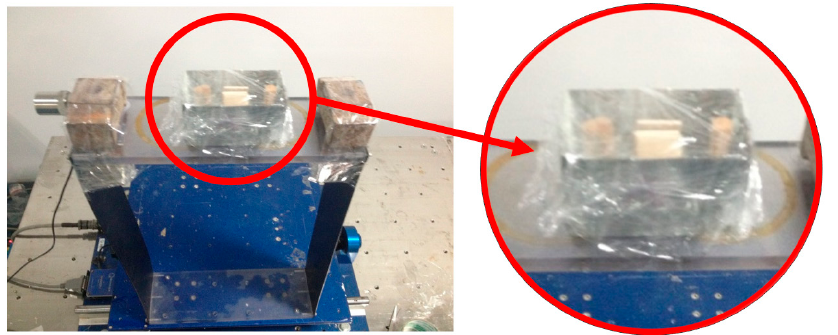
Figure 3. Picture of KV-TLD and the whole experimental device.